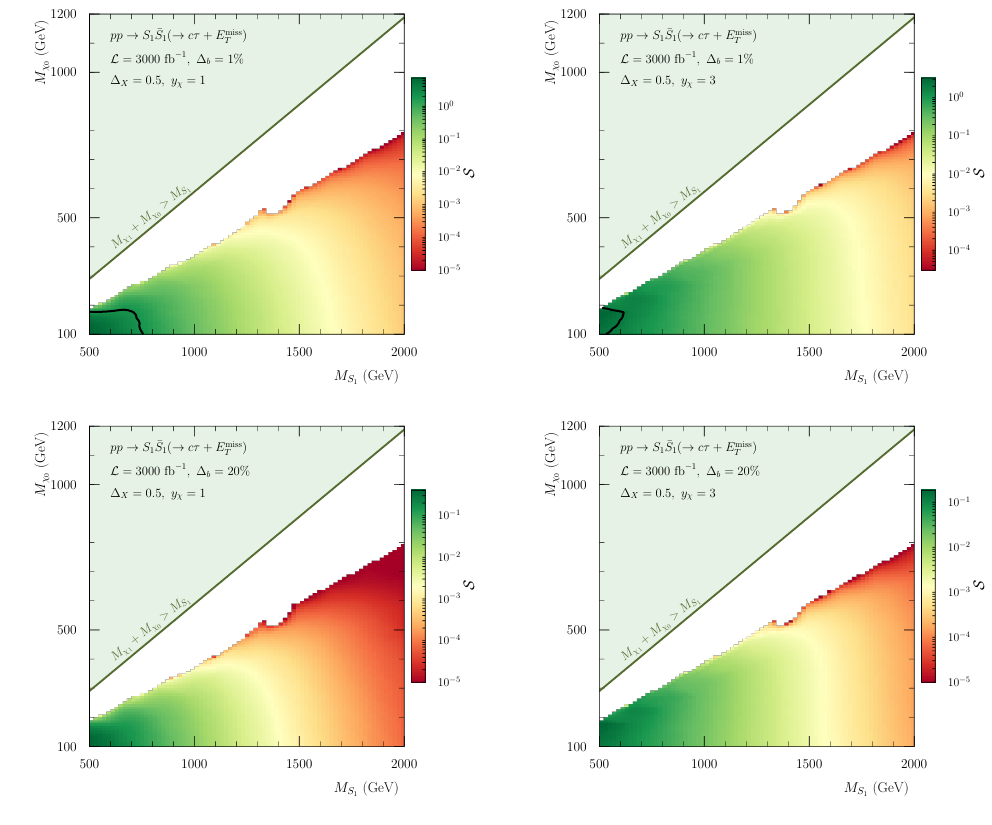
Figure 27 . Same as figure 26 but for ∆ X = 0 . 5